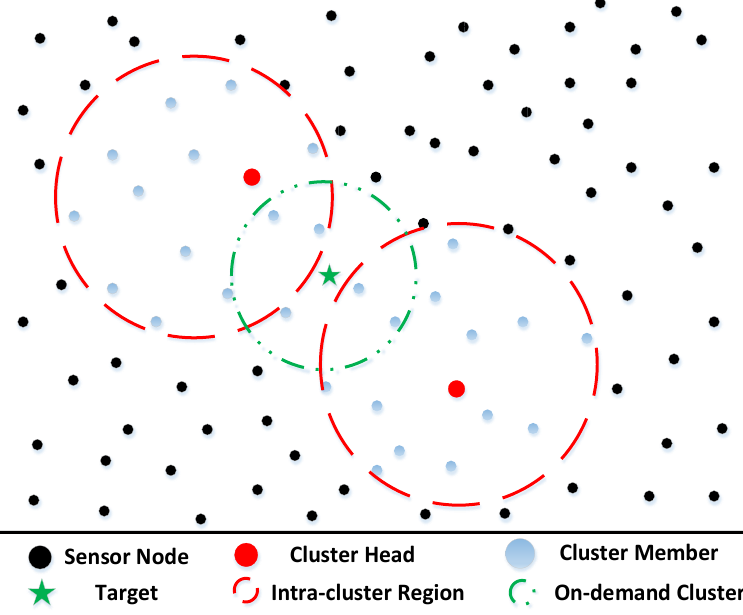
Figure 2. On-demand cluster between static cluster.